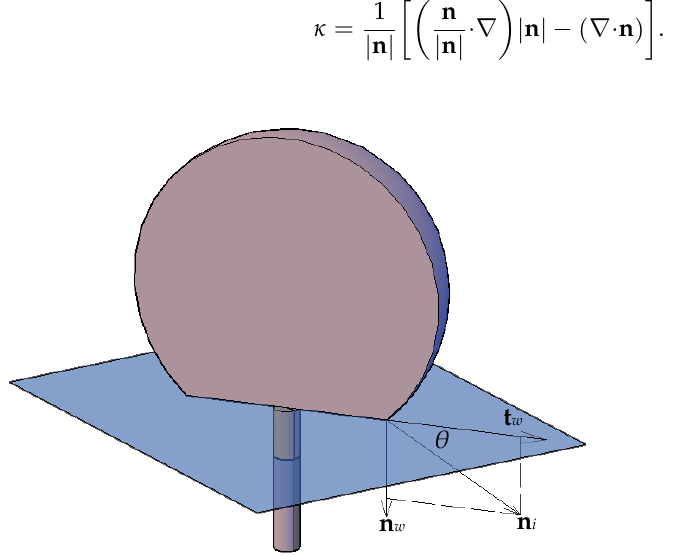
Figure 9. A 3D representation of the interface with the unit normal vector in the cells at the walls along the contact line.